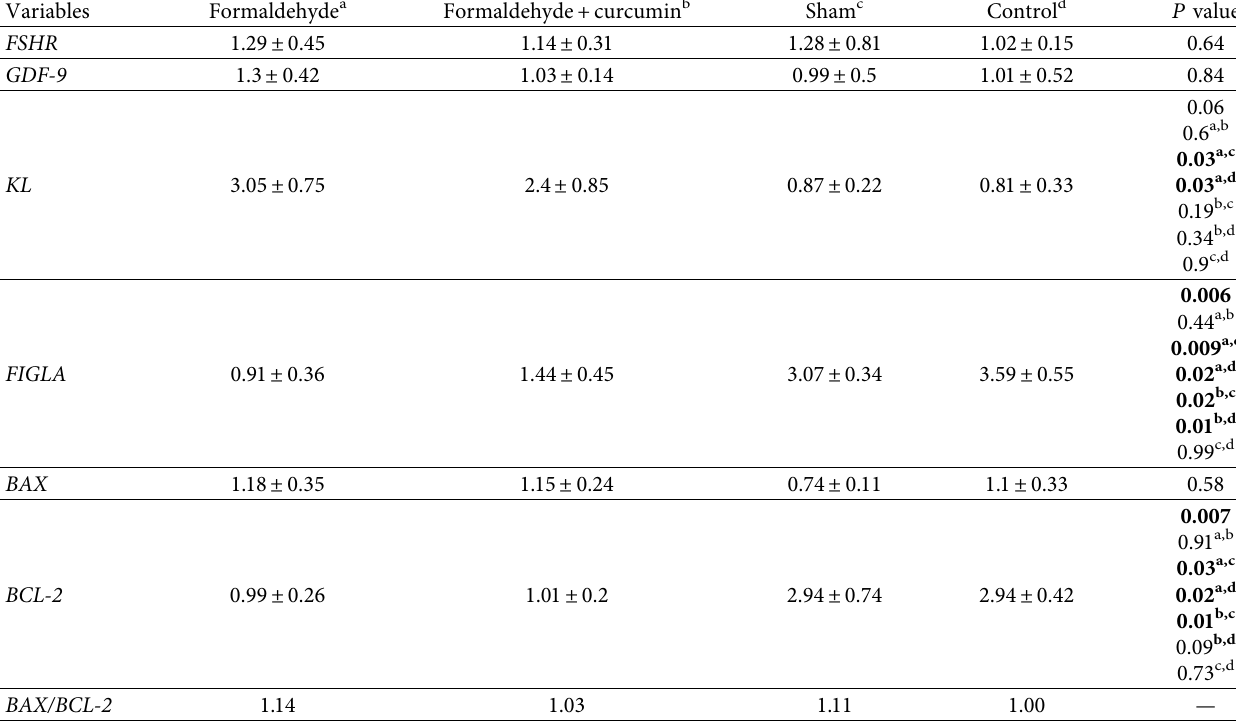
FSHR : follicle-stimulating hormone receptor, GDF-9 : growth diferentiation factor-9, FIGLA : factor in germ line alpha, Kl : klotho , BCL-2 : B-cell lymphoma 2, and BAX : BCL-2-like protein 4. Te data were shown as the mean ± SEM. Te Mann–Whitney and Kruskal–Wallis tests were carried out, respectively, to compare two and all groups. SEM: standard error of mean. P < 0.05 was considered as bold